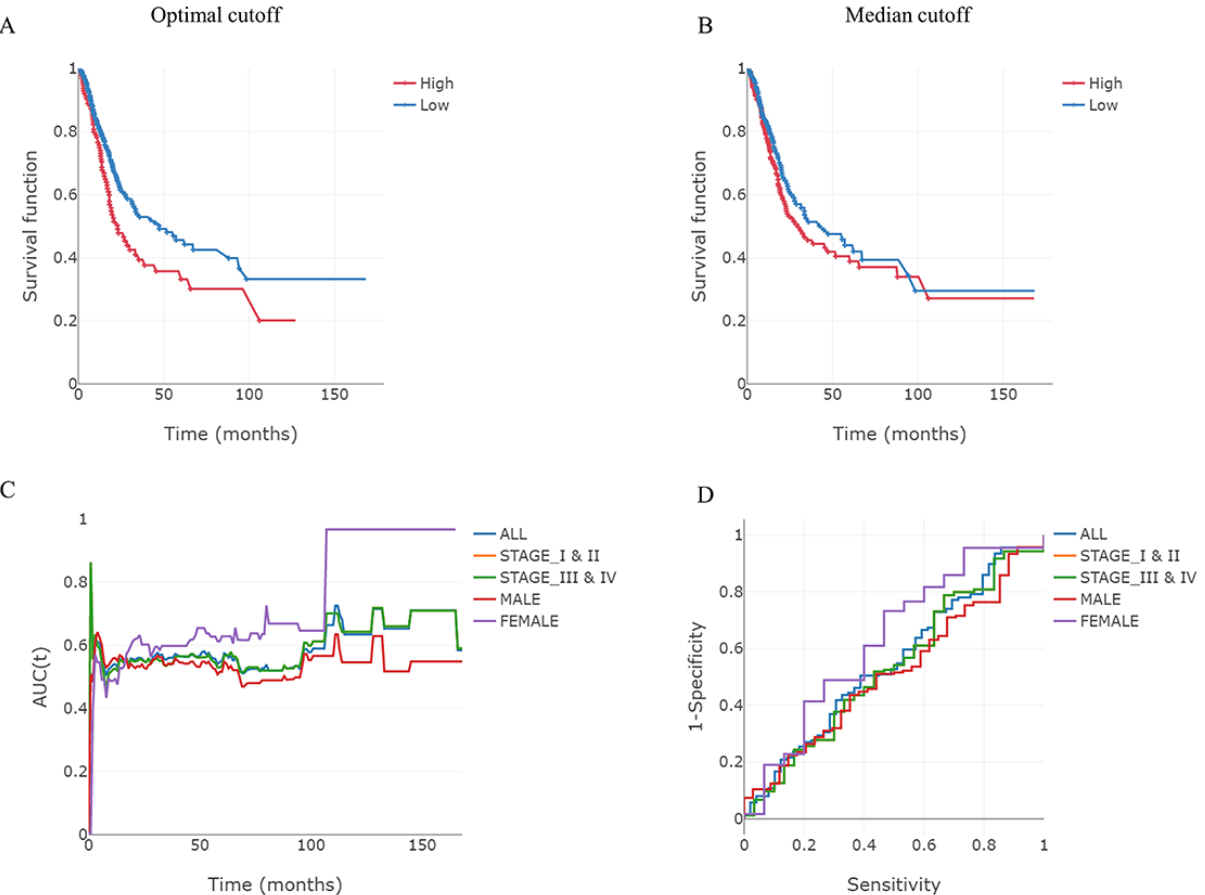
Figure 2. An example of mRNA-based survival analysis. Expression levels of genes are classified as low or high (blue or red lines, respectively) based on the comparison of their optimal (A) and median cut-off values (B). (C) Time-dependent area under the curve (AUC) for each of these subgroups. (D) Receiver operating characteristics (ROC) curves for selected years in each of these